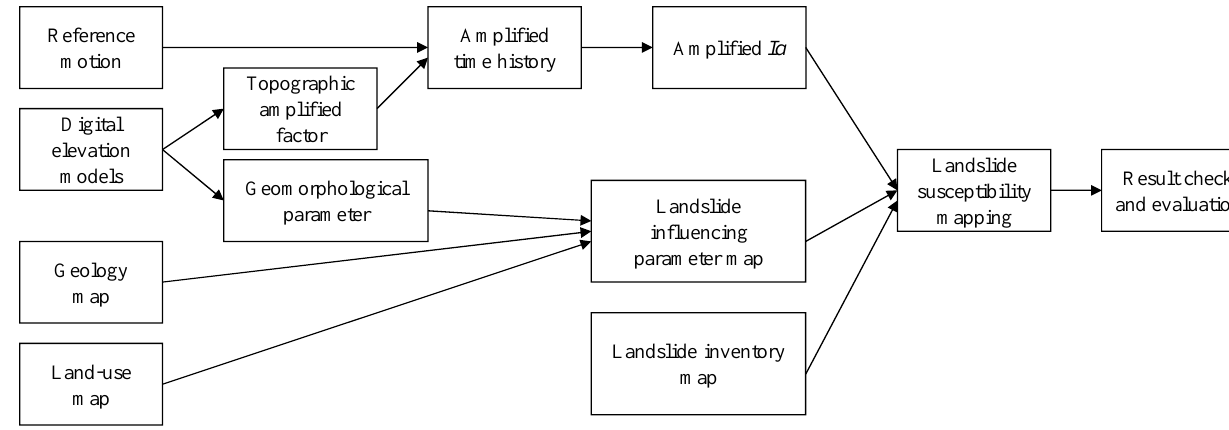
Fig. 1 Flowchart of the proposed method. 615 Fig. 1. Flowchart of the proposed method.